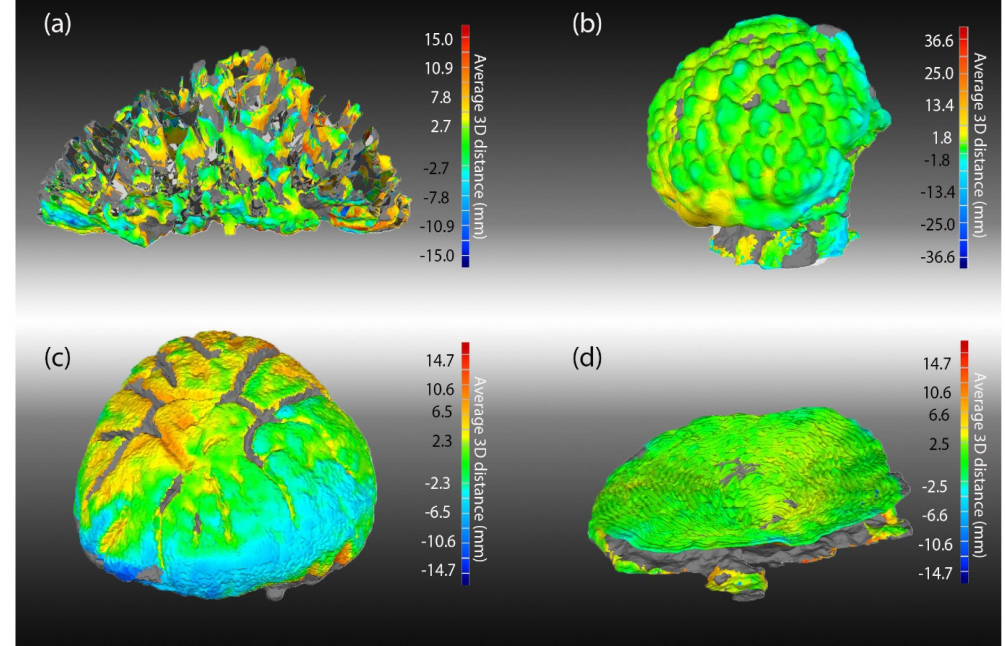
Figure 6. Accuracy analysis of 3D models of each morphology. The heatmap shows the distance (mm) between the laser scan reference model and the average (of all replicates) model for each morphology: ( a ) Foliose; ( b ) Massive-small; ( c ) Massive-medium; and ( d ) Tabulate. Areas where there was no model overlap are indicated in